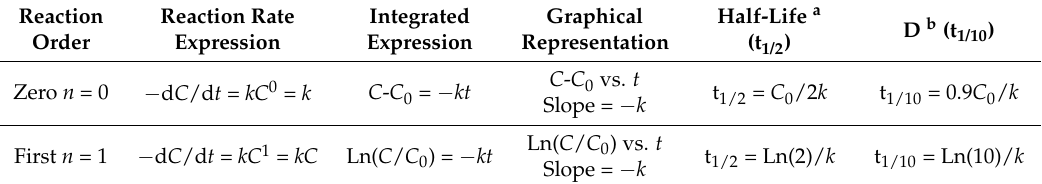
Integrated Graphical Half-Life a D b (t 1/10 ) Expression Representation (t 1/2 ) C - C 0 vs. t t 1/2 = C 0 /2 k t 1/10 = 0.9 C 0 / k Slope = − k